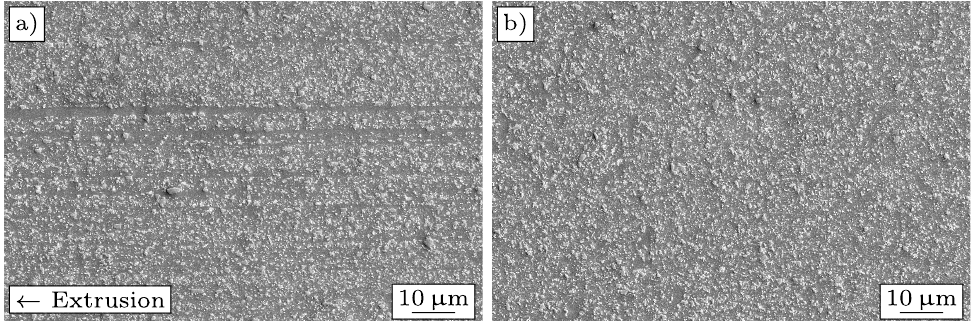
Figure 1. Microstructure of the investigated composite which was also addressed in previous investigations [23,24]. The figure presents scanning electron microscopy (SEM) images of cross sections ( a ) parallel and ( b ) perpendicular to the extrusion